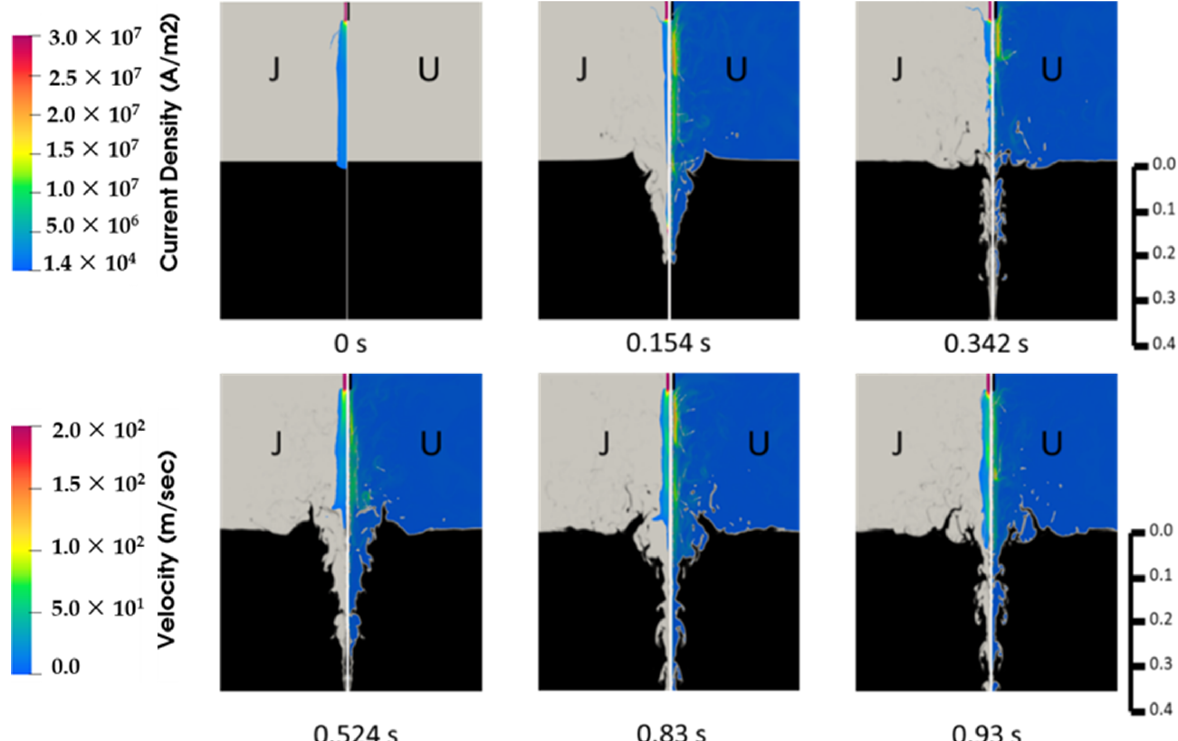
Figure 9. Liquid metal impingement by an arc jet for a 3.0 × 10 −1 m gap distance.